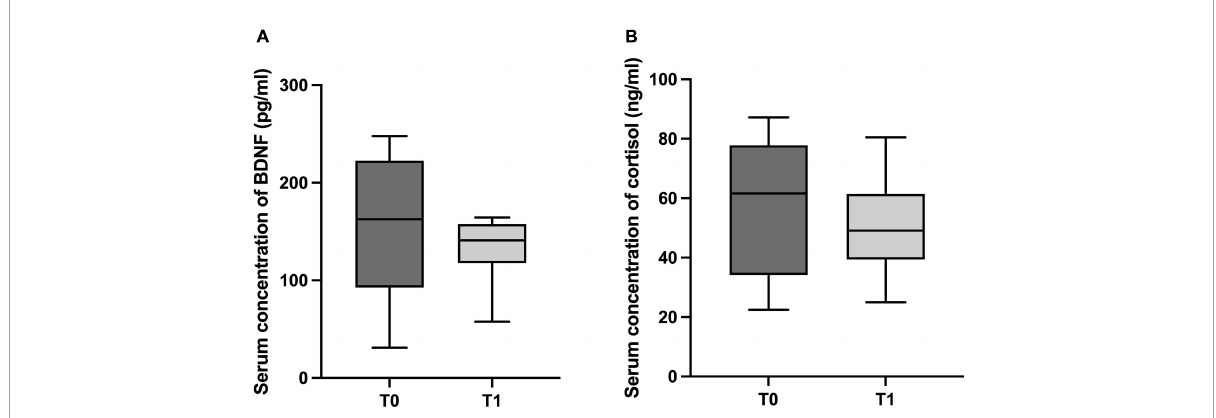
FIGURE3 The boxplots show the median/minimum-maximum values for serum concentration of neurological markers before (T0) and after 6 months of physical distancing (T1). (A) Brain-derived neurotrophic factor (BDNF) in pg/ml (T0: 201.00/84.33-247.70 and T1: 141.00/57.67-164.30); (B) Cortisol in ng/ml (T0: 60.34/22.44-85.96 and T1: